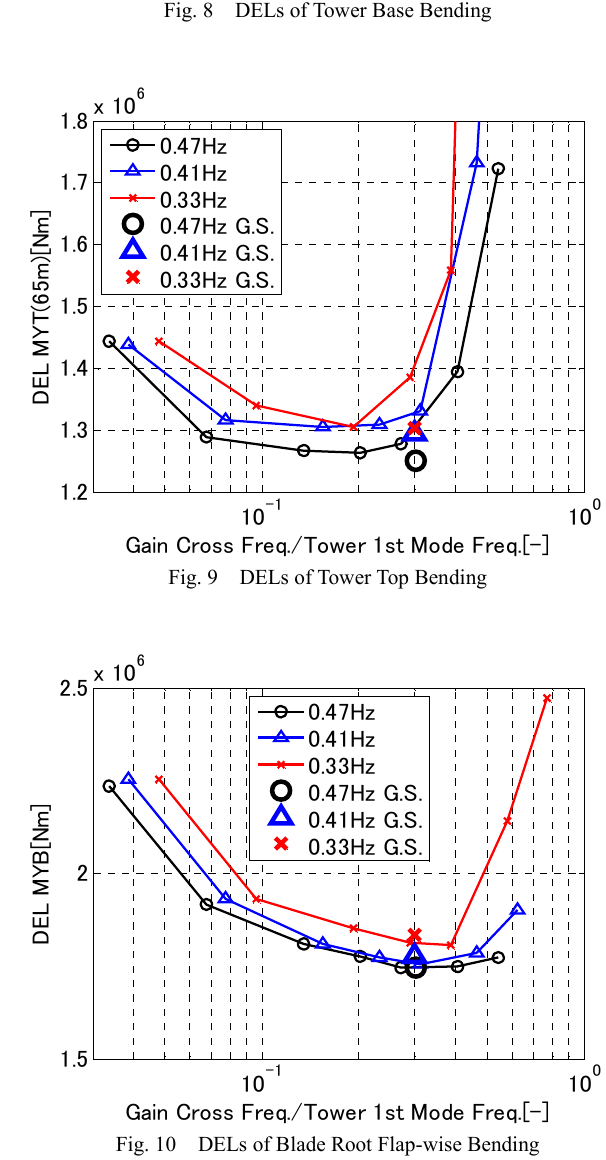
Fig. 8 DELs of Tower Base Bending